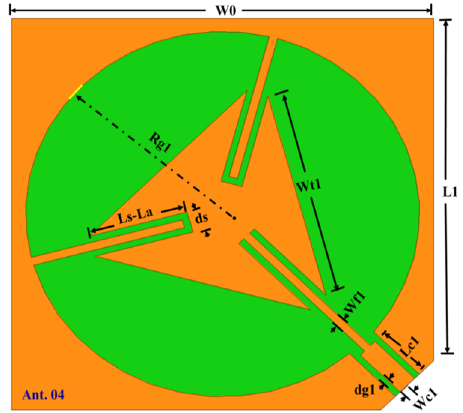
Figure 4. Configuration of the constructed Slot antenna 4. Table 1. Physical parameters of proposed slot antenna 1.